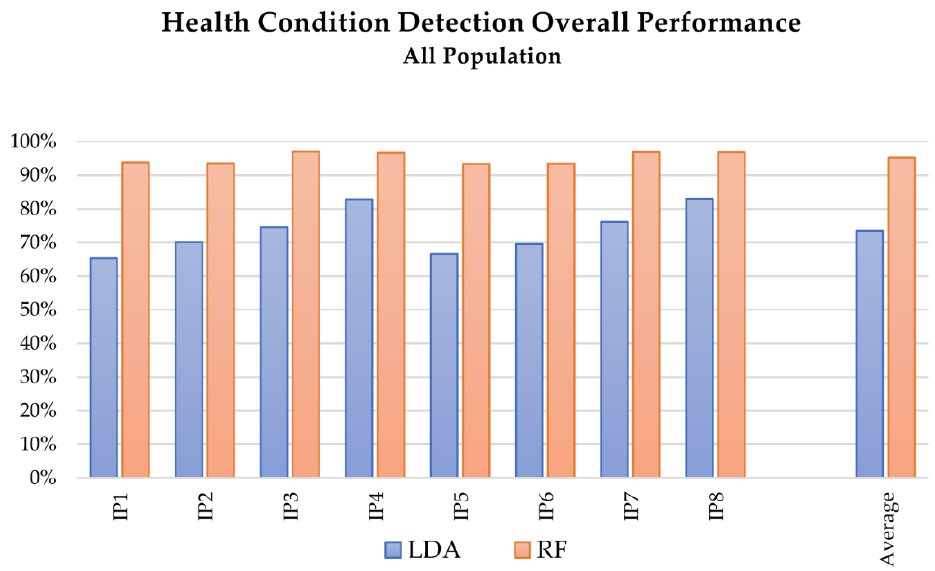
Figure 6. Mean accuracy of the health condition detection for the analysis of complete dataset (healthy and pathological subjects) with respect to the applied MLT: blue and red the results of the testing with LDA and RF, respectively.